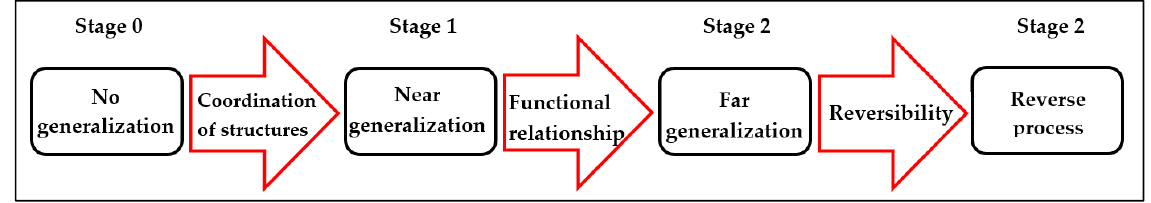
Figure 1. Progression model of pattern generalization.